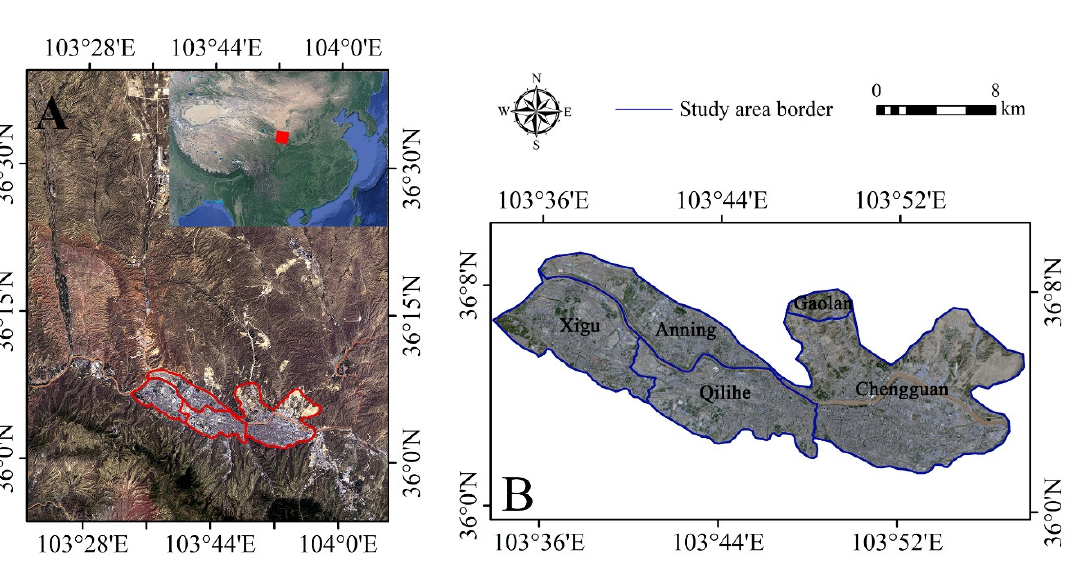
Figure 2. The location of the study area. ( A ) The location on the map and ( B ) detailed distribution of municipal areas of Lanzhou.